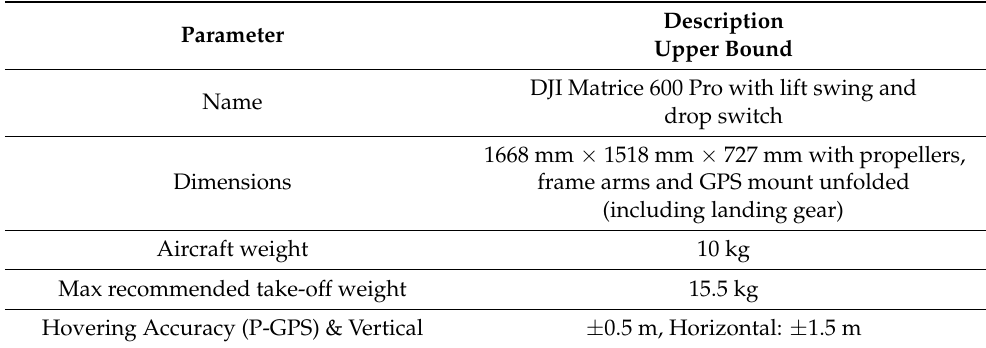
Figure 1. ( left ) Picture of DJI Matrice 600 Pro UAV; ( right ) The metal sphere used for the calibration experiment. Table 1. Specifications of the UAV used for calibration experiment.